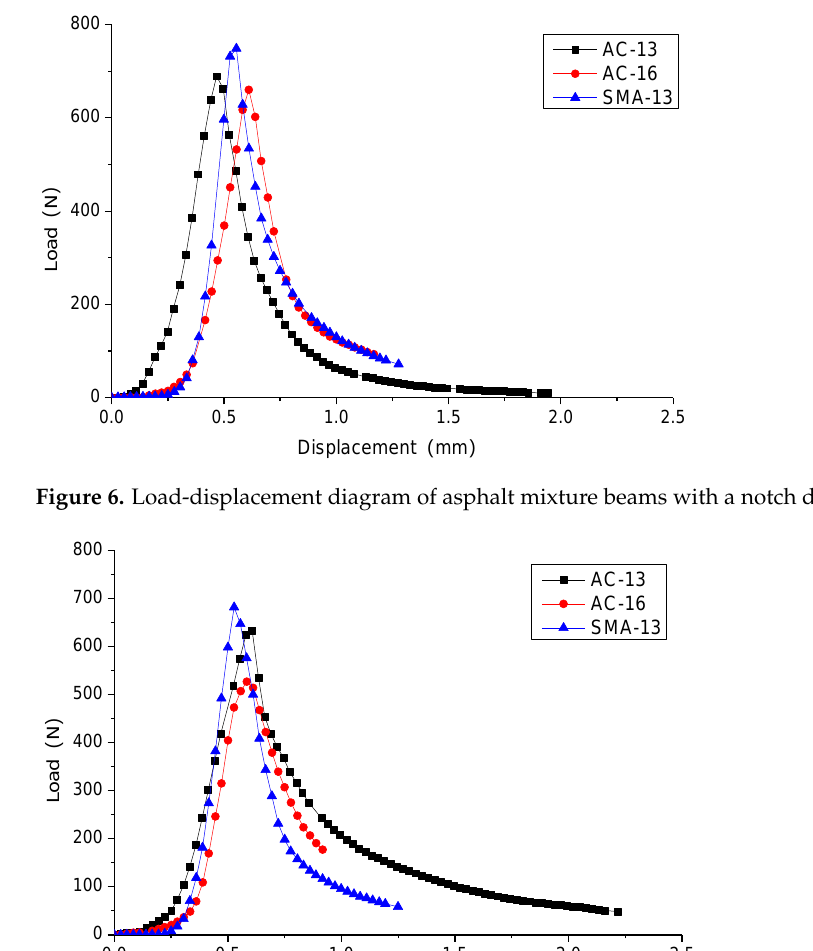
Figure 5. Load-displacement diagram of asphalt mixture beams with a notch depth of 4 mm.